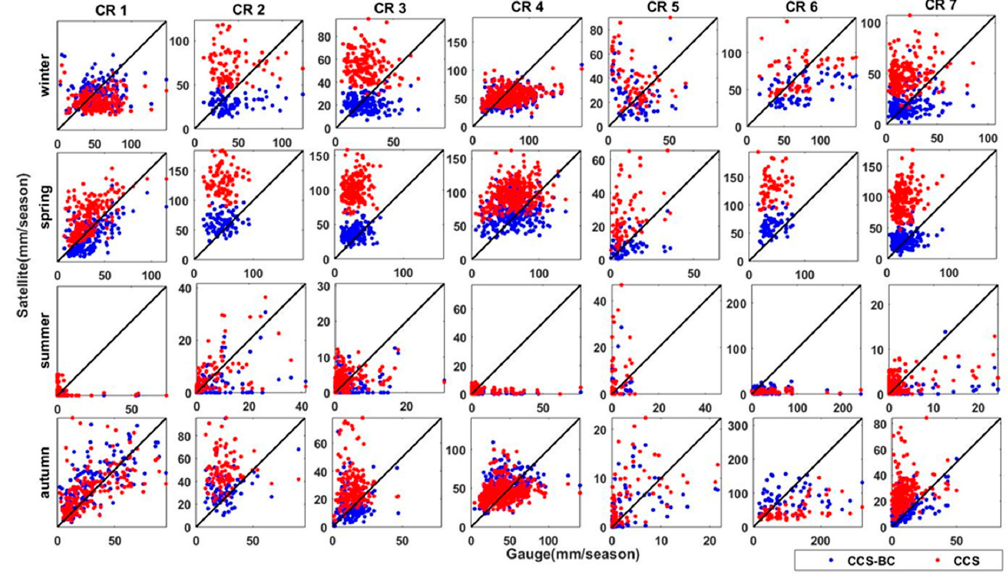
Figure 8. Scatter plots of the CCS and CCS-BC mean seasonal precipitations versus the gauge mean seasonal precipitation in gauged pixels for the seven CRs for the validation period.